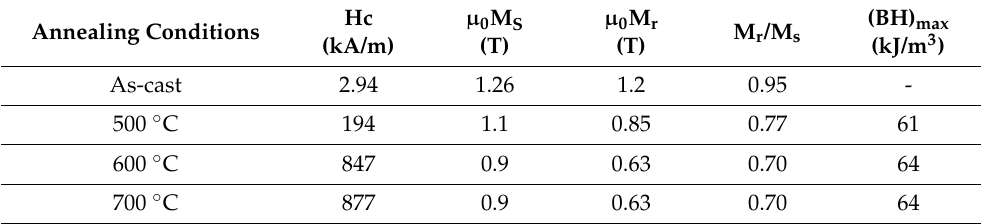
Table 4. Magnetic parameters obtained for annealed samples at 300 K in parallel applied